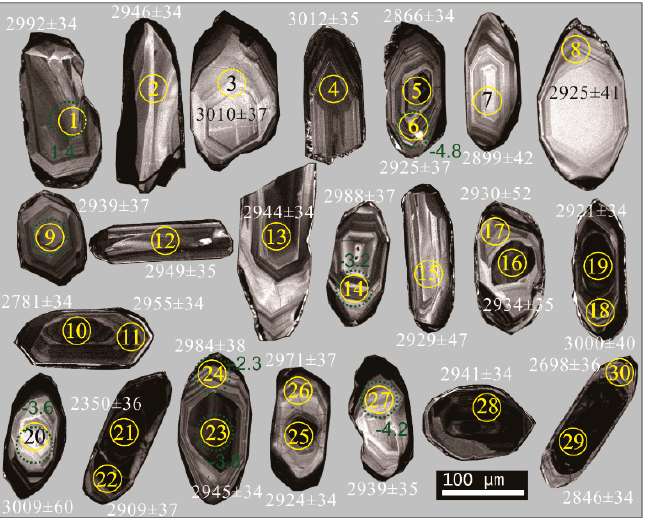
Figure 8. Representative cathodoluminescence images of zircons from the trondhjemitic gneiss (D0002-3). Symbols are as in Figure 4.